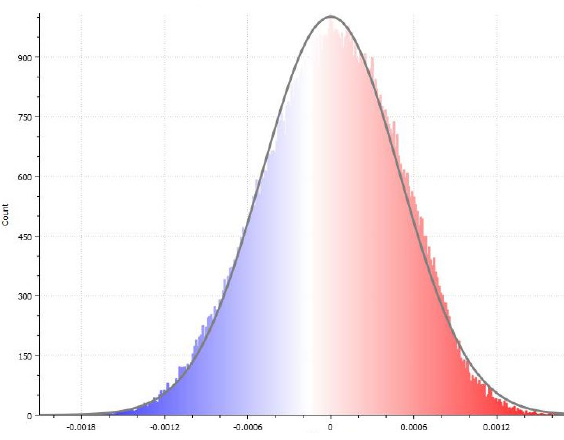
Figure 8. Typical distribution of residuals of plane fitting to TLS data; Patch 1 of Wall 1 (x is given in